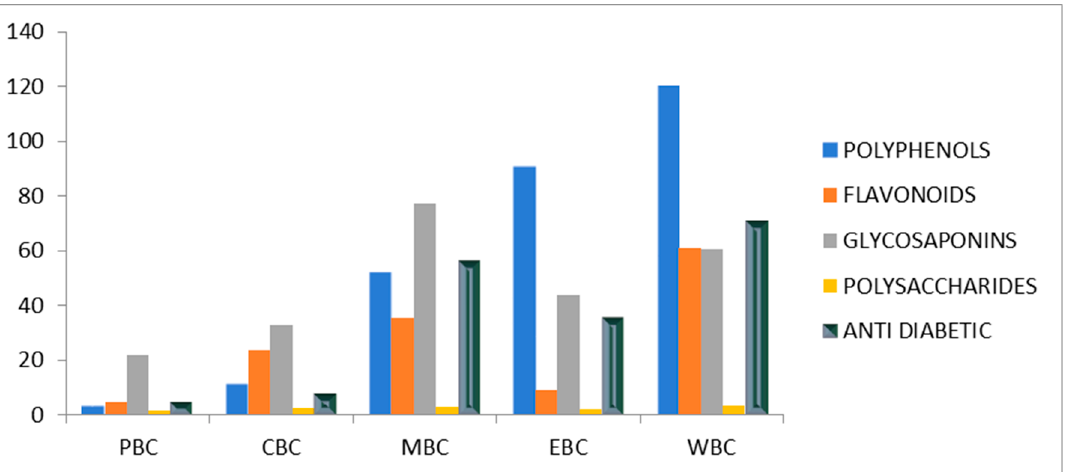
Figure 8. Comparison of secondary metabolites and antidiabetic activity in Bombax ceiba L. Note: